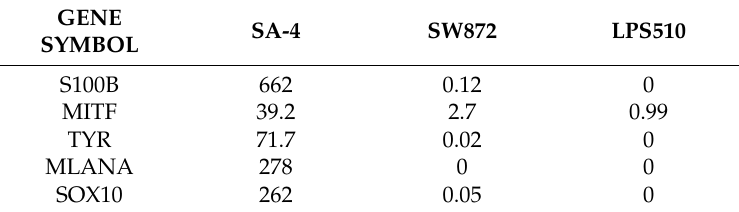
Table 3. Endogenous mRNA